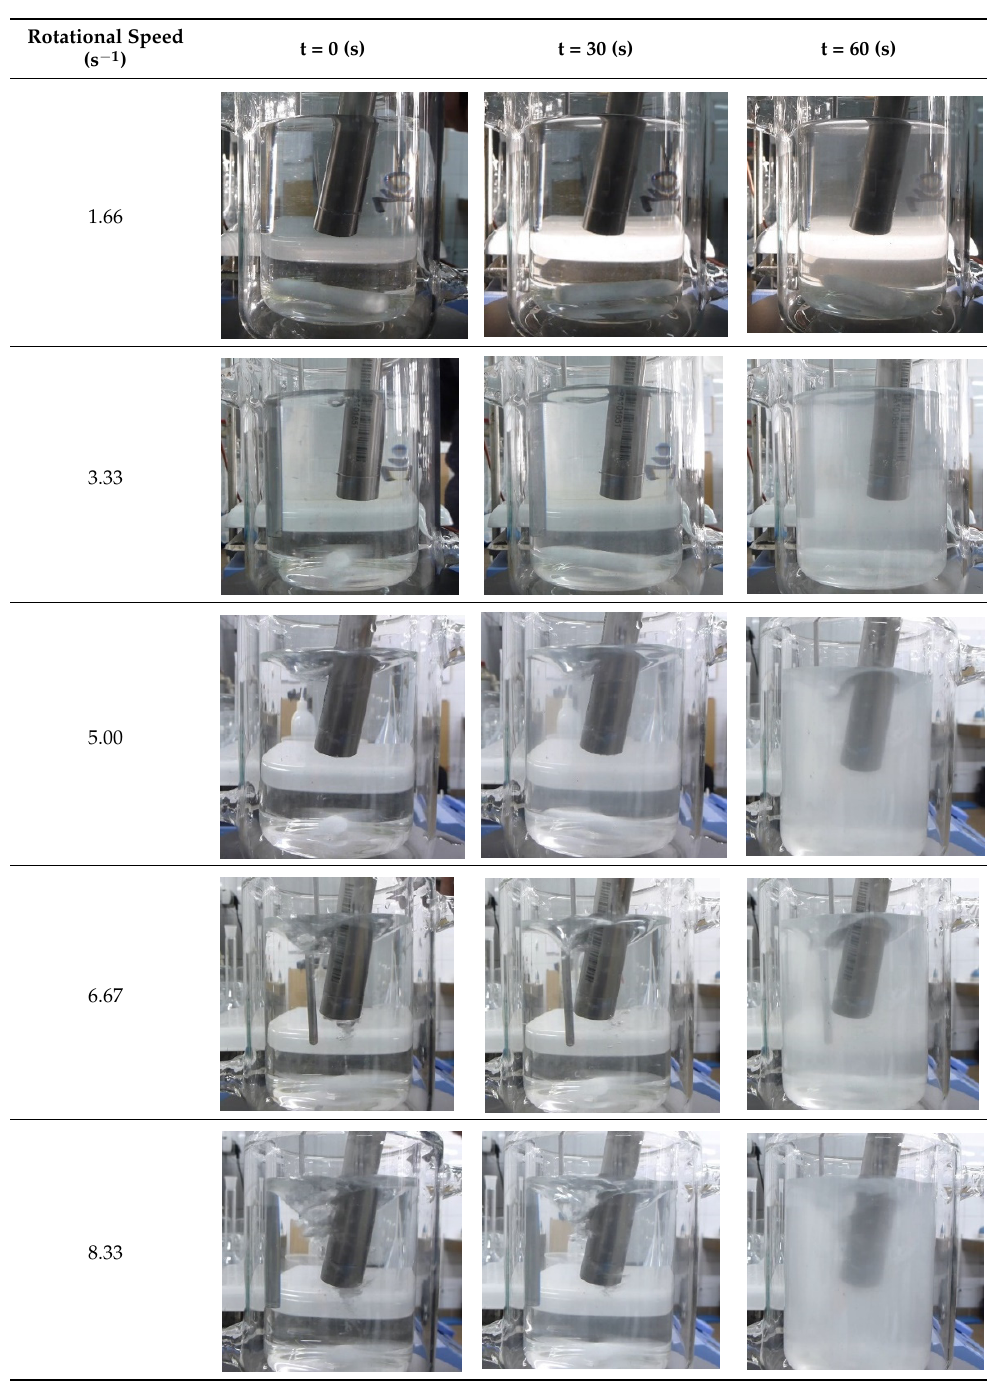
Table 5. Comparison of turbidity of solution during precipitation for various rotational speed.